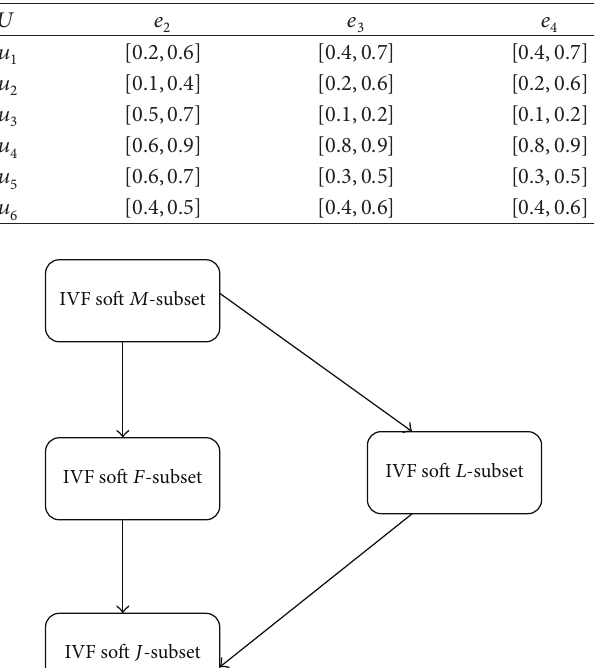
Table 3: Tabular representation of the IVF soft set B 2 . Table 4: Tabular representation of the IVF soft set B 3 .